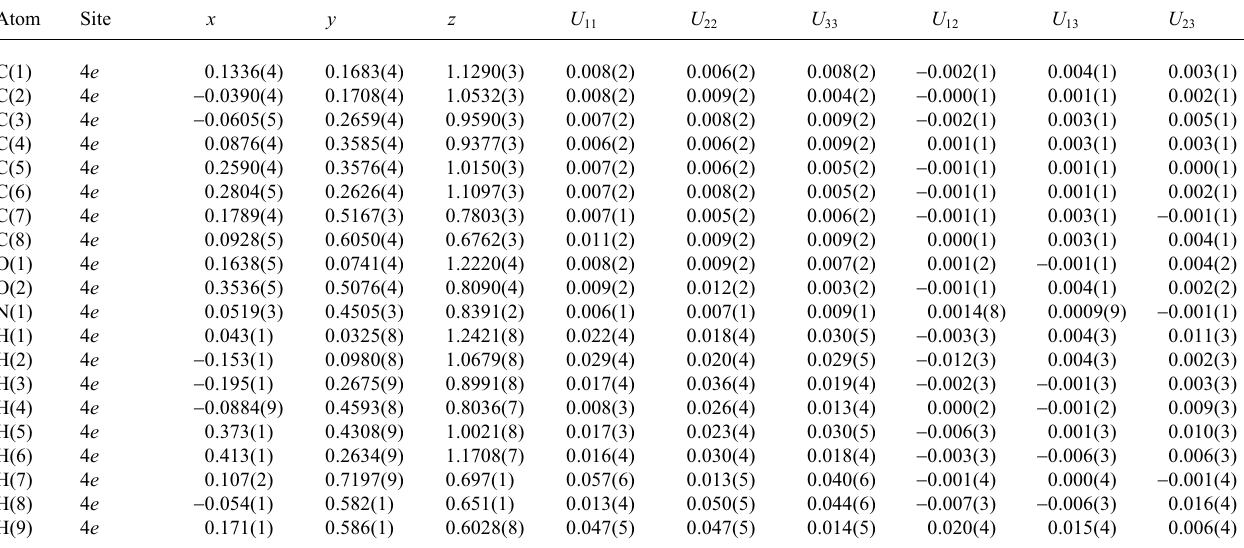
Table 2. Atomic coordinates and displacement parameters (in Å 2 )